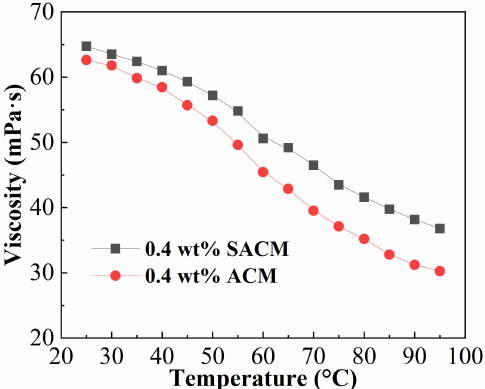
Figure 4. Effect of temperature on viscosity of suspension diluent and powder